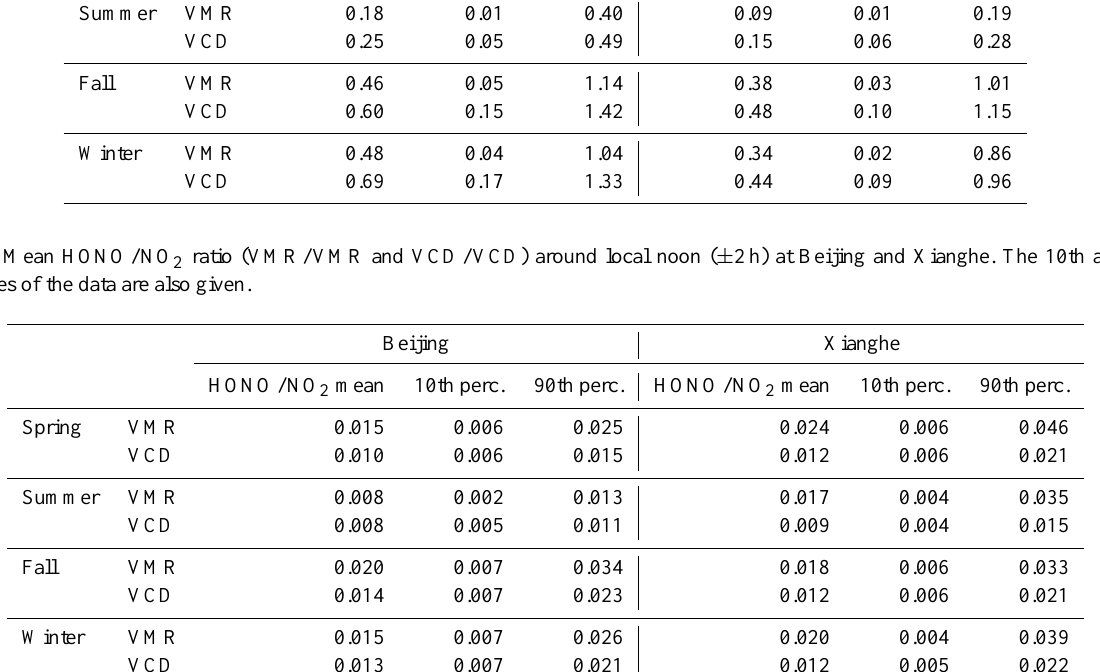
Table 3. Mean HONO near-surface concentration (VMR in ppb unit) and vertical column density (VCD in 10 15 moleccm − 2 units) around local noon ( ± 2h) at Beijing and Xianghe. The 10th and 90th percentiles of the data are also given. Beijing Xianghe HONO mean